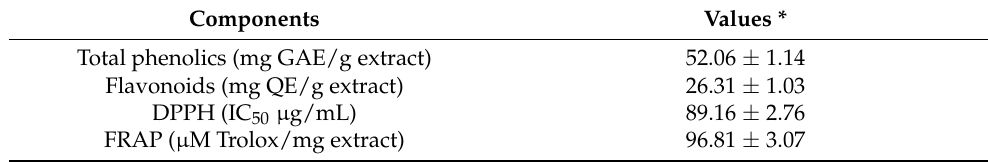
Table 2. Total flavonoids and phenolics content as well as antioxidant properties of RCFE. Components Values * Total phenolics (mg GAE/g extract) 52.06 ± 1.14 Flavonoids (mg QE/g extract) 26.31 ± 1.03 DPPH (IC 50 µ g/mL) 89.16 ± 2.76 FRAP ( µ M Trolox/mg extract) 96.81 ±